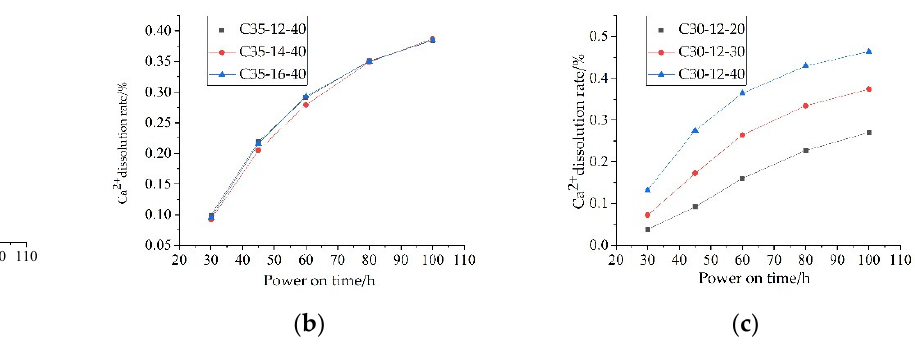
Figure 4. Change curve of calcium ion dissolution rate: ( a ) different concrete strength grades; ( b ) different reinforcement diameters; ( c ) different energizing voltage.